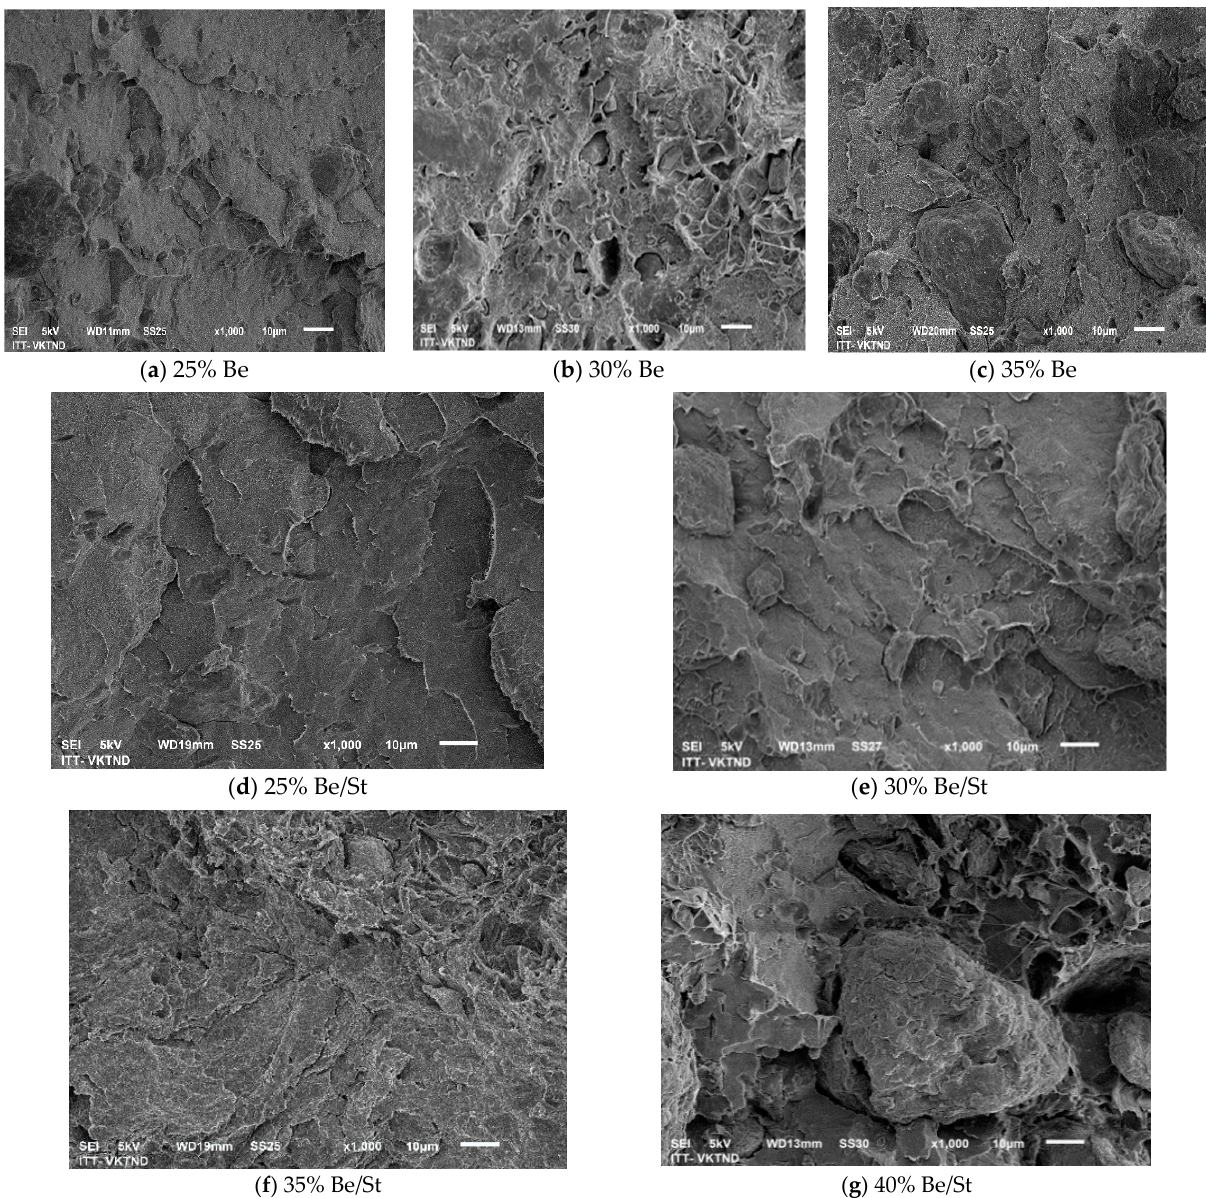
Figure 2. The morphology of the fracture surface of untreated and treated bentonite/PE masterbatches.